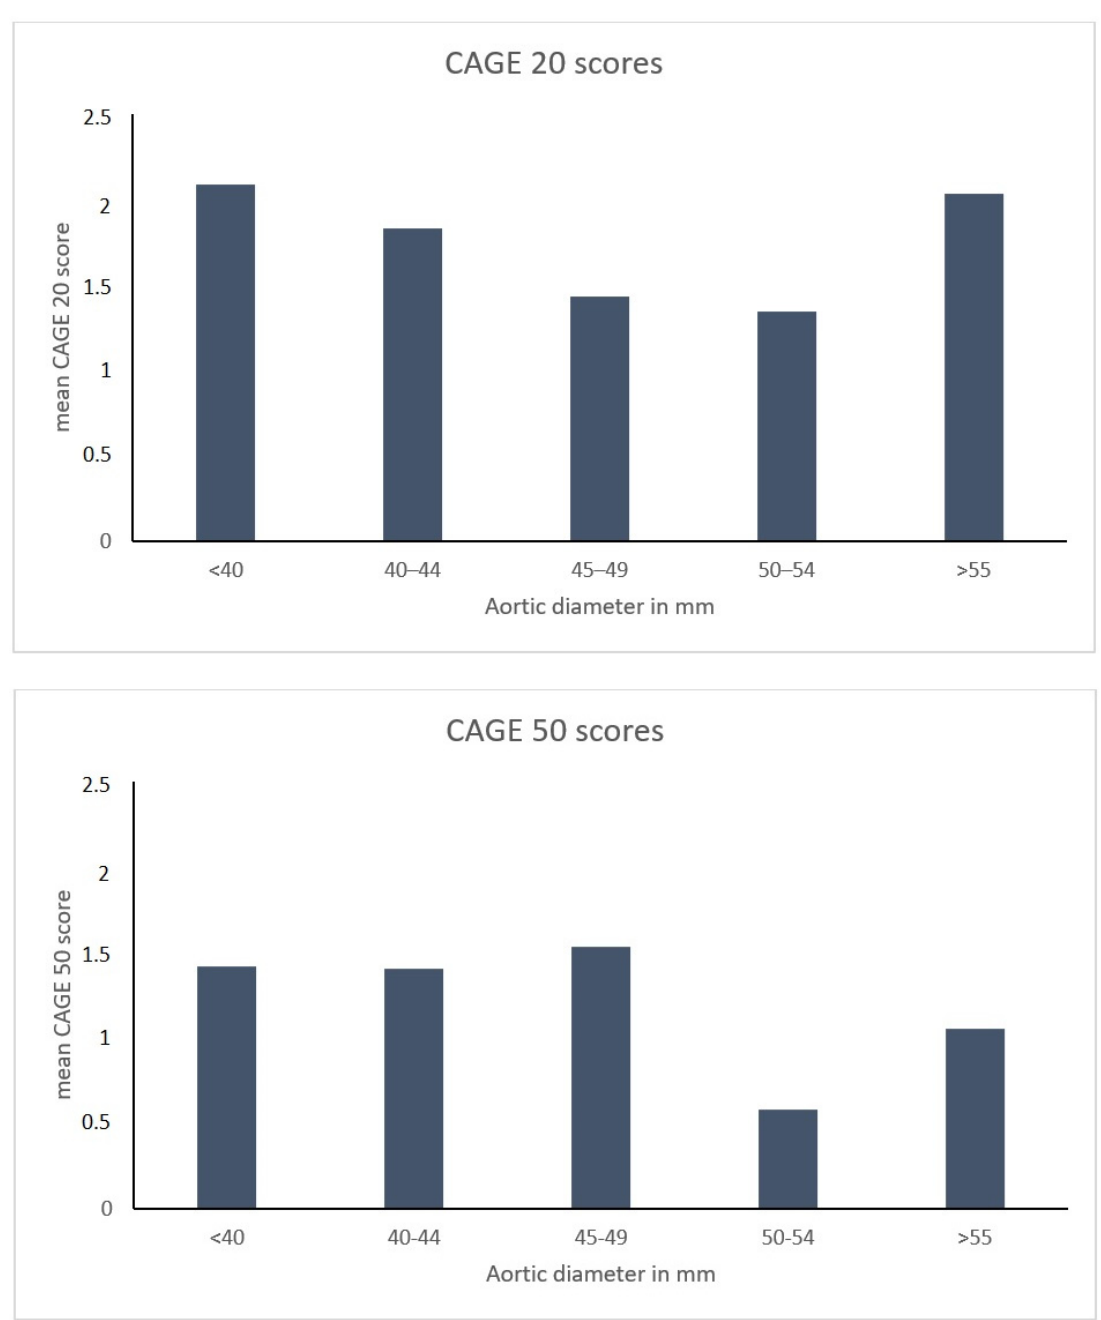
Figure 2. CAGE scores per diameter. Sensitivity analysis using ascending aortic diameter as a con- tinuous variable did not indicate a correlation between CAGE 20 scores (upper figure, p = 0.894) or CAGE 50 scores (lower figure, p = 0.317) and aortic diameter.